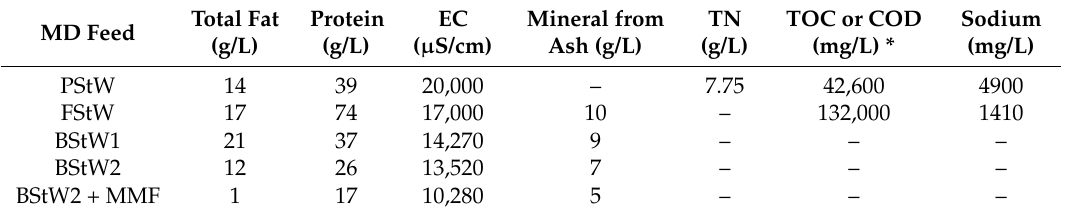
Table 1. Water quality parameters of poultry stick water (PStW), fish stick water (FStW), and bovine stick water (BStW) (week 1 & 2) feed samples, including the permeate from metal membrane microfiltration (MMF) of BStW2 fed to membrane distillation